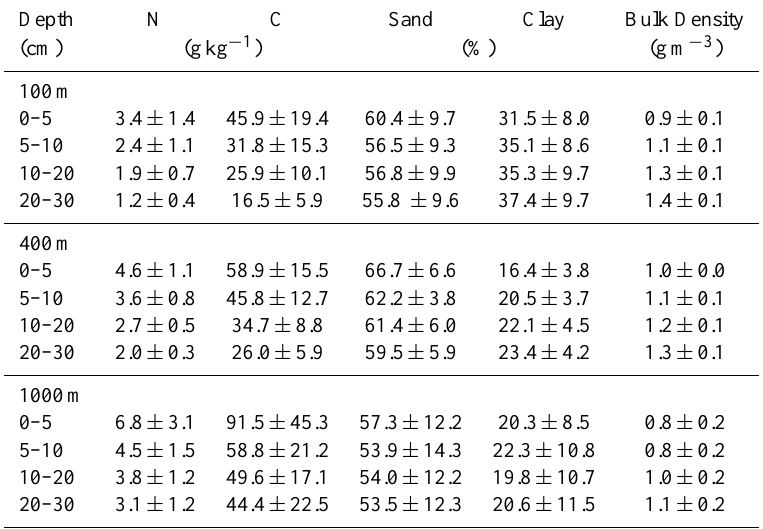
Table 1. Physical-Chemical characterization of the soil layers (0.3m depth) sampled at the studied sites (mean ± standard error; n = 32 for each altitude and depth). Data source: Martins,